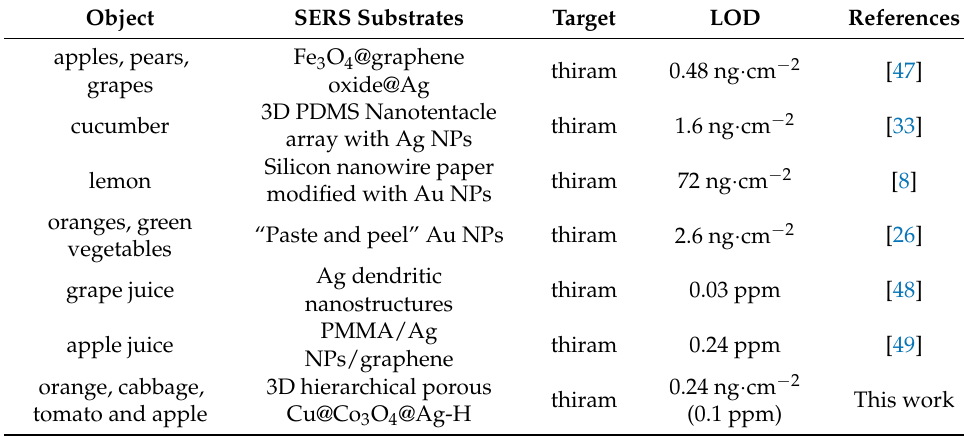
Figure 7. Raman spectra of thiram on the Cu@Co 3 O 4 @Ag-H substrate. ( a ) SERS spectra of thiram at different concentrations from 100 ppm to 800 ppt. ( b ) Relationship between the intensity of the SERS peak at 559 cm -1 , 1380 cm -1 and the thiram concentration; the error bar is based on four parallel SERS spectra. ( c ) Raman spectra and ( d ) corresponding intensity of 559 cm -1 ,1145 cm -1 , 1380 cm -1 of thiram (100 ppb) collected from four different fruits and vegetables. Table 1. SERS performance of thiram detection on different SERS